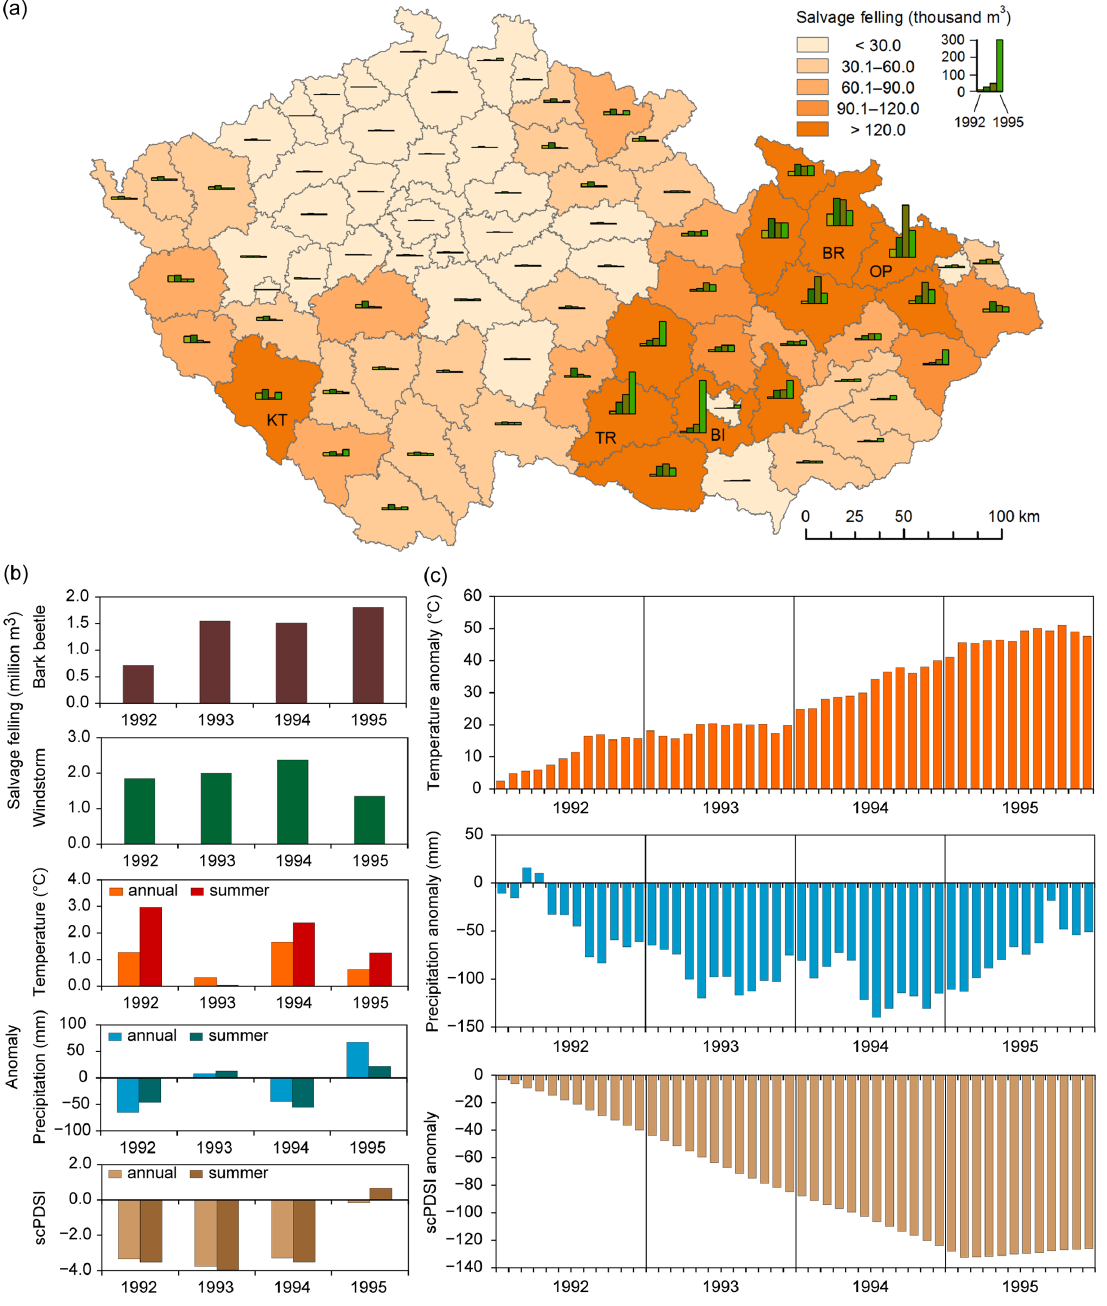
Figure 8. Bark beetle outbreak of the 1990s on the territory of the Czech Republic: (a) the volume of bark beetle salvage felling in 1992– 1995 in individual districts; (b) annual bark beetle and windstorm salvage felling, annual and summer anomalies of temperature, precipitation, scPDSI-12, and scPDSI-3 in 1992–1995; (c) cumulative monthly anomalies of temperature, precipitation, and scPDSI in 1992–1995 (1961– 1990 reference period). Abbreviations of districts: BI – Brno-venkov; BR – Bruntál; OP – Opava; KT – Klatovy; TR – T ˇ rebí ˇ